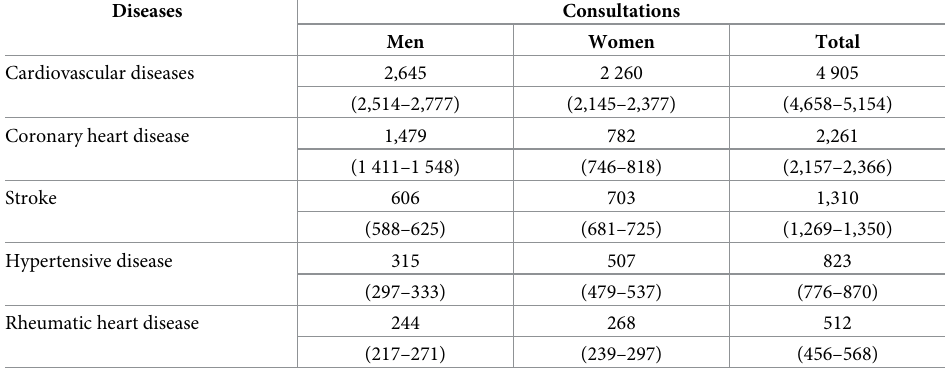
Table 4. Estimated costs (thousand USD $) of consultation by CVD type and gender for the CCSS due to excessive salt intake in Costa Rica, 2018 (95% uncertainty intervals). Diseases